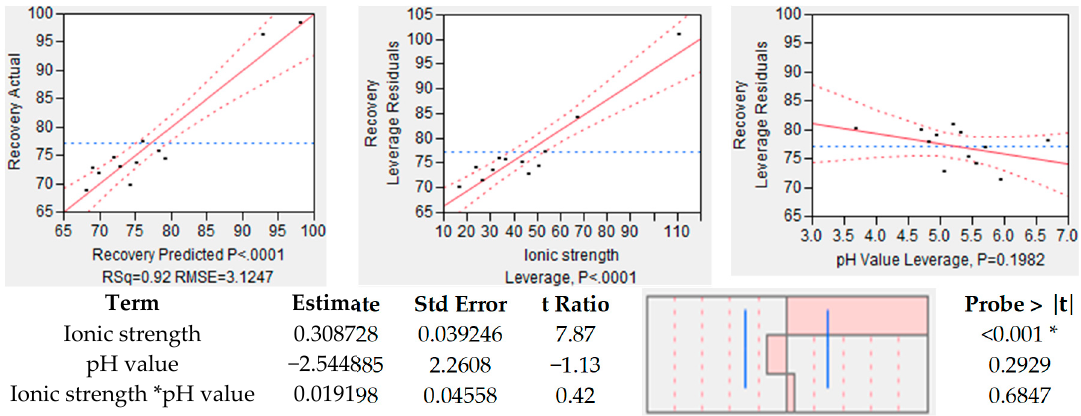
Figure 10. Statistical analysis of the design of experiments (DoE) results regarding mAb recovery. (Left) prediction model of mAb recovery is shown. (Middle) leverage effect analysis of recovery regarding ionic strength. (Right) leverage effect analysis of recovery regarding pH value. Results of effects and significances are shown below the figures. The asterisk means that term is statistically significant.